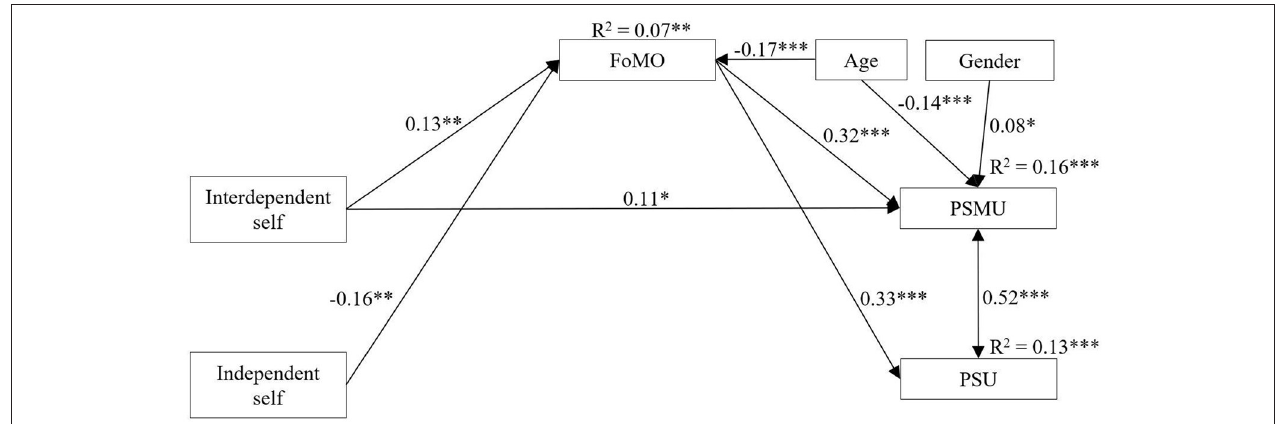
FIGURE 1 | Final estimated path model. For clarity, only the significant relationships are depicted in the figure. FoMO, fear of missing out; PSU, problematic smartphone use; PSMU, problematic social media use. * p < 0.05; ** p < 0.01; *** p < 0.001.